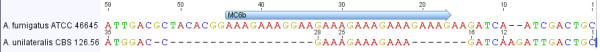
Alignment of the marker MC6b sequences in Aspergillus fumigatus and Aspergillus unilateralis .